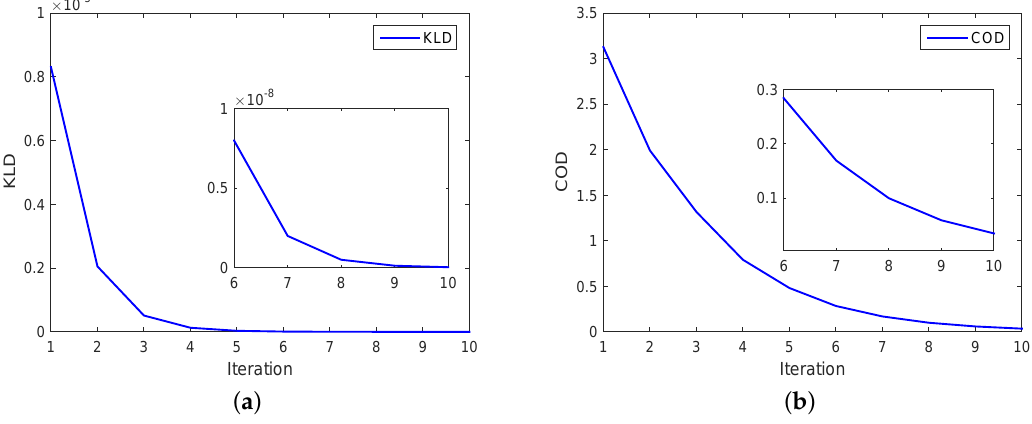
Figure 7. Value of metrics versus the number of iterations for PEKF-VB and CODEKF. ( a ) KL divergence in PEKF-VB, ( b ) COD in